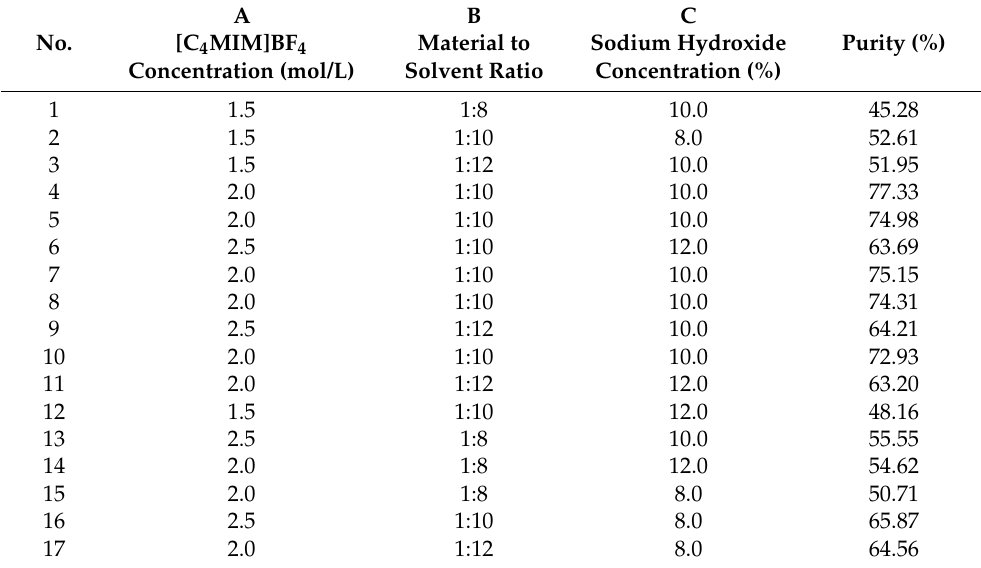
Table 2. Box–Behnken experimental design and the purification of saponins ( n = 3).